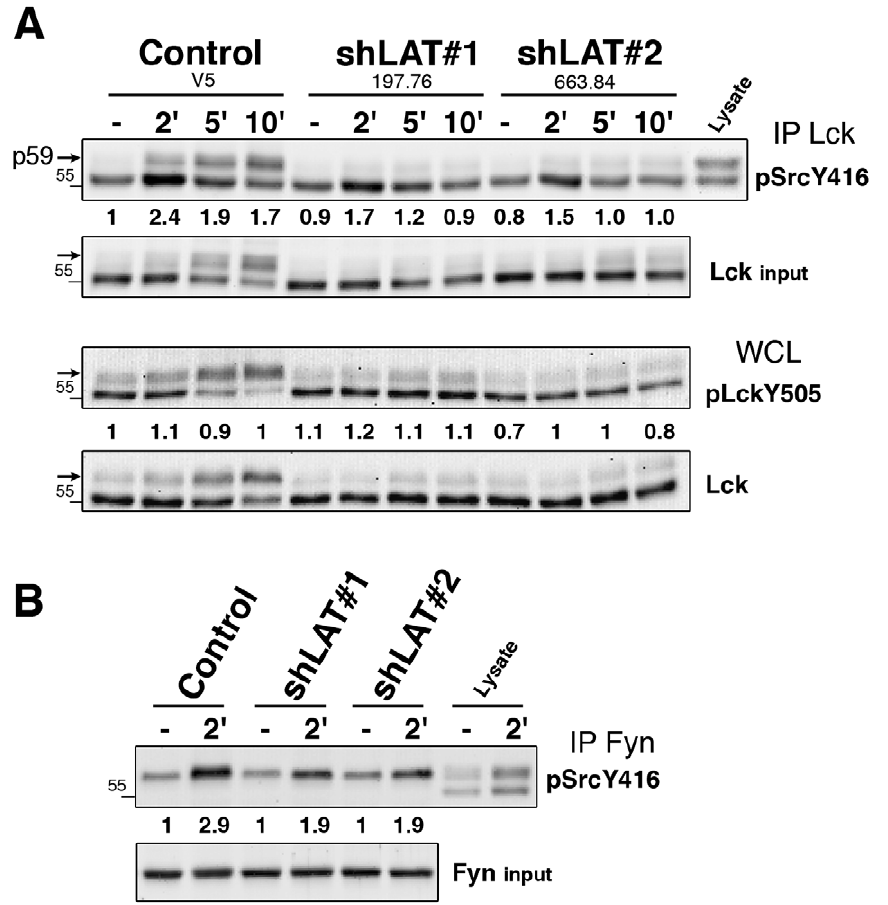
Figure 4. LAT promotes phosphorylation of Lck and Fyn activatory tyrosines. (A) Lck immunoprecipitates from control and Hut-shLAT cells stimulated with anti-CD3 were analyzed for Tyr394 phosphorylation by immunoblotting with anti-pSrcY416. Aliquots of cell lysates were probed with anti-Lck (Lck input) and with anti-LckY505. (B) Fyn immunoprecipitates were analyzed for Tyr417 phosphorylation with anti-pSrcY416. Numbers indicate fold inductions of phosphorylation after normalization to protein loading and unstimulated control cells. Data are representative of three independent experiments.